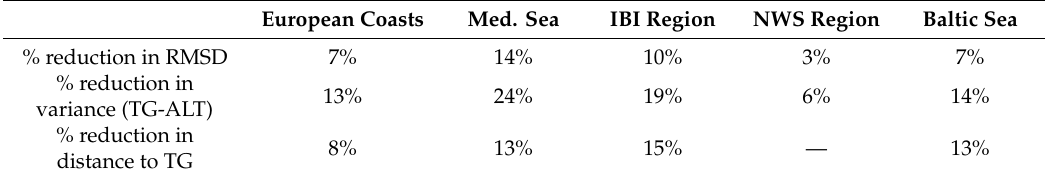
Table 7. Summary of the improvements (%) of the Sentinel-3A mission in the comparison with tide gauges in terms of the lower RMSD, lower variance of the di ff erences (altimetry—tide gauge), and lower mean distance between the most correlated altimetry point and tide gauges with respect to Jason-3 in the European coasts, and the di ff erent sub-regions investigated. The analysis is similar to that shown in Tables 1 and 2 (last column) but using LWE-uncorrected SLA data. European Coasts Med. Sea IBI Region NWS Region Baltic Sea % reduction in RMSD 7% 14% 10% 3%